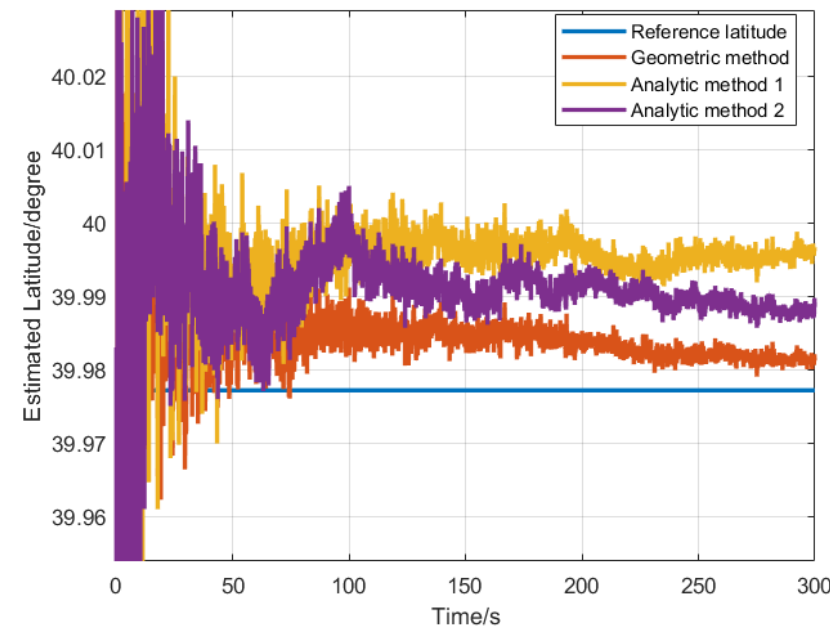
Figure 11. The latitude estimation curve of real INS test. Table 6. The LD results at the same position. (The reference geographic latitude is 39.977200 ◦ (N)).